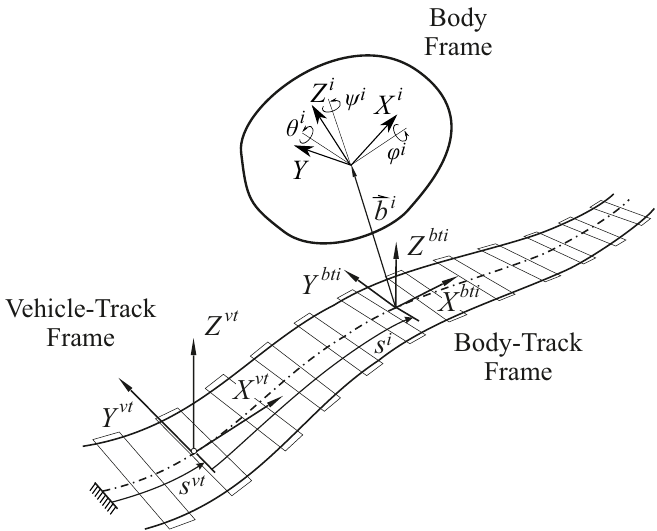
Figure 1. Frames of reference and kinematic description of arbitrary vehicle